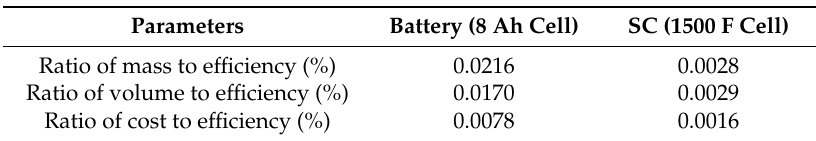
Table 5. Efficiency density parameters of battery/SC